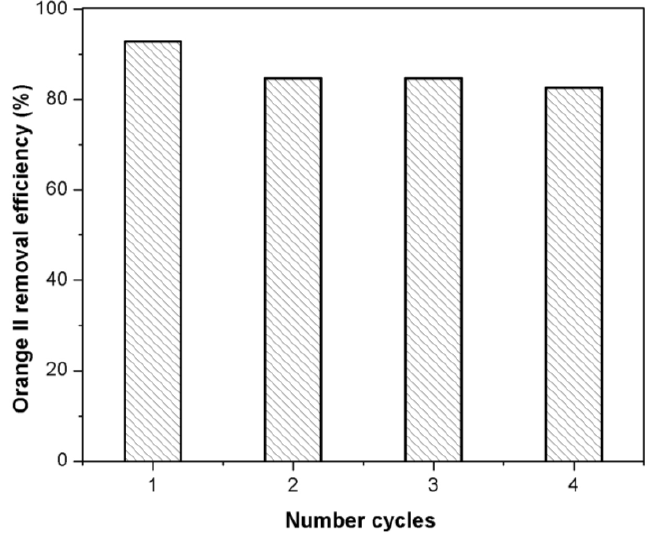
Figure 10. Orange II removal of the recycled Fe(BTC) (initial concentration: 25 mg·L −1 ; adsorbent mass: 10 mg; temperature: 298 K; pH